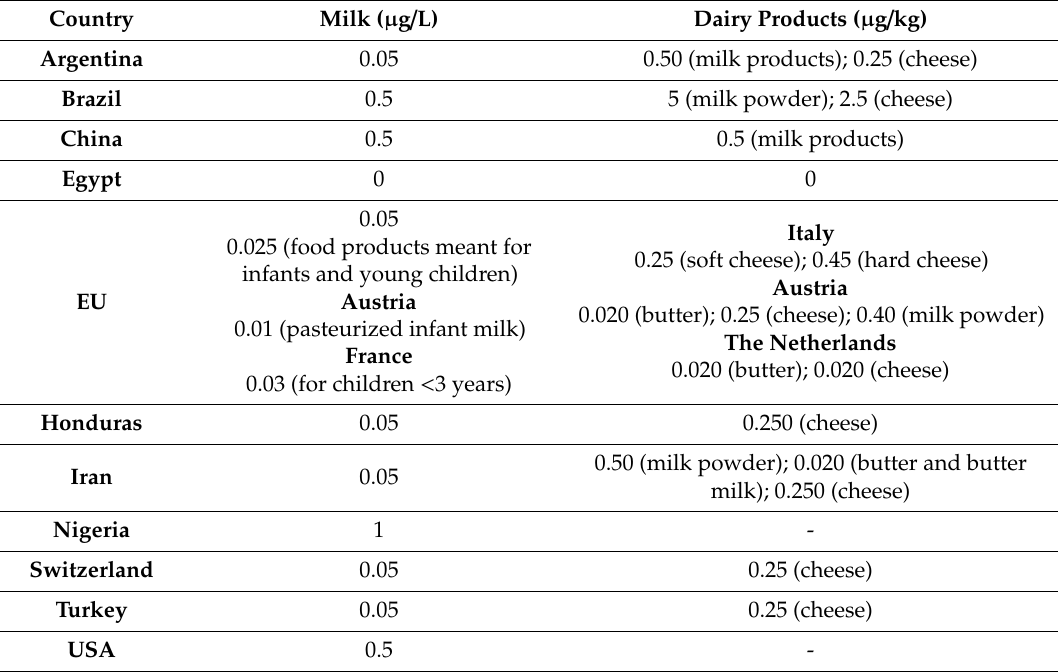
Table 1. Regulation of aflatoxin M1 in dairy products in di ff erent countries [6,14,15]. Country Milk ( µ g /